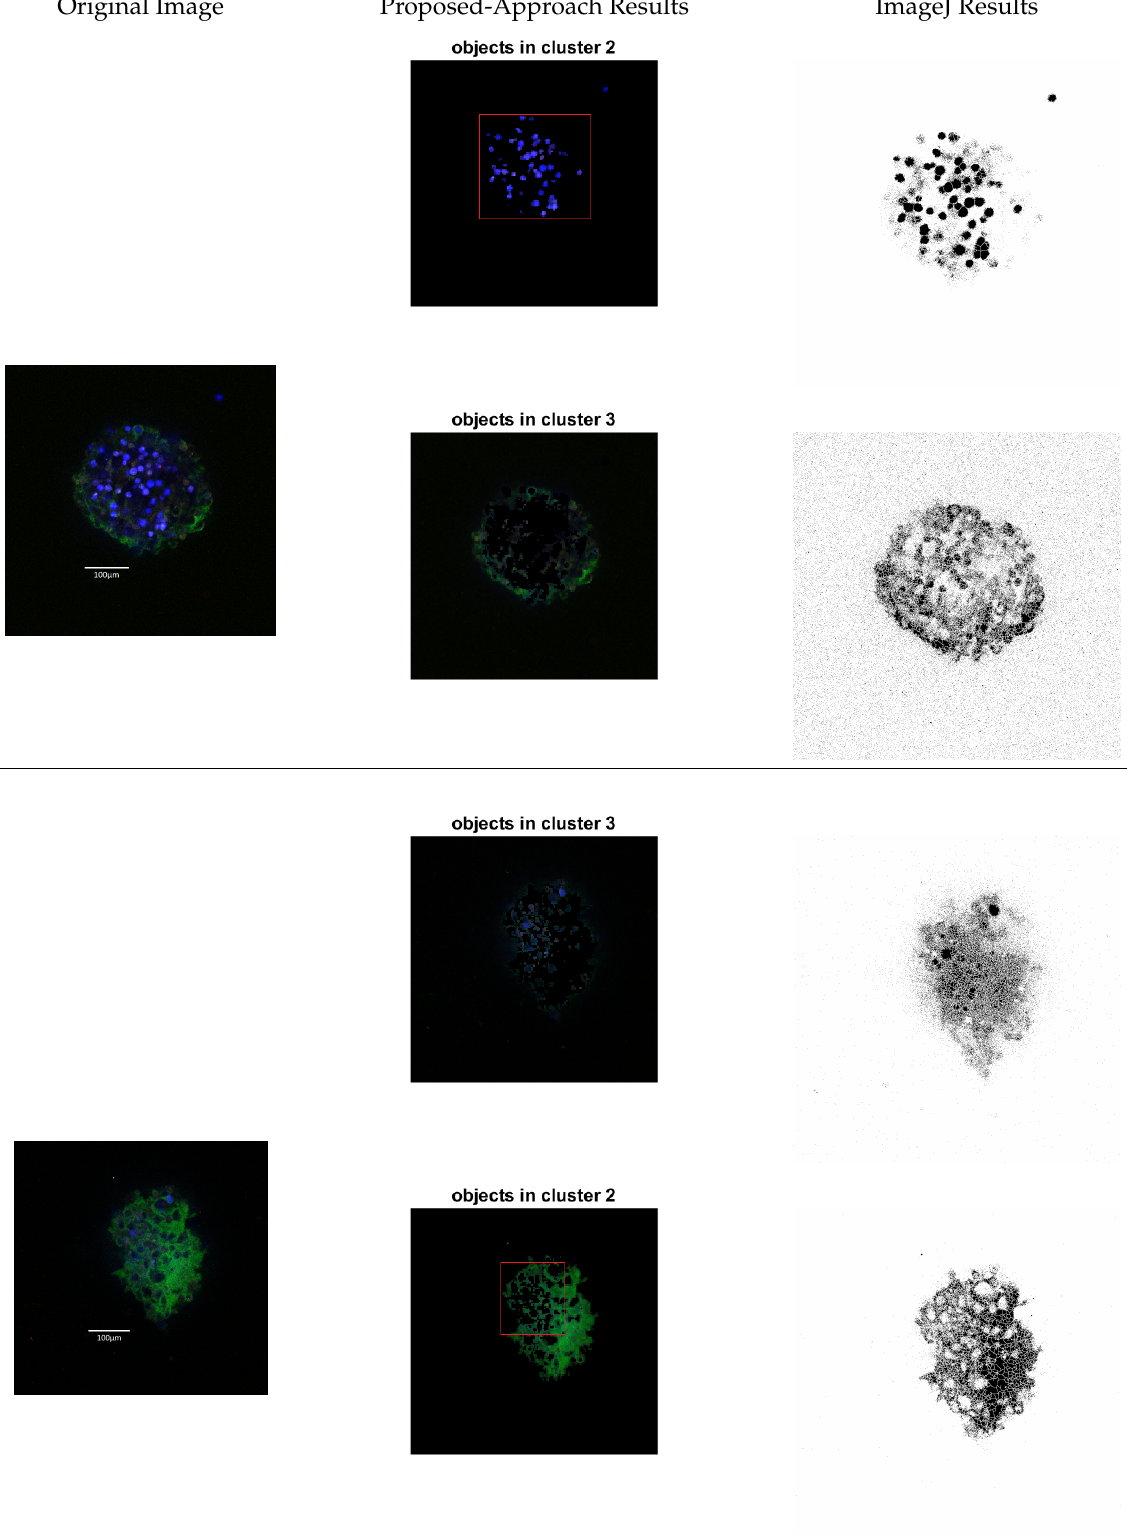
Figure 11. Comparison of TLBO algorithm and ImageJ software based on segmentation of HCT-8 and NIH3T3 cell